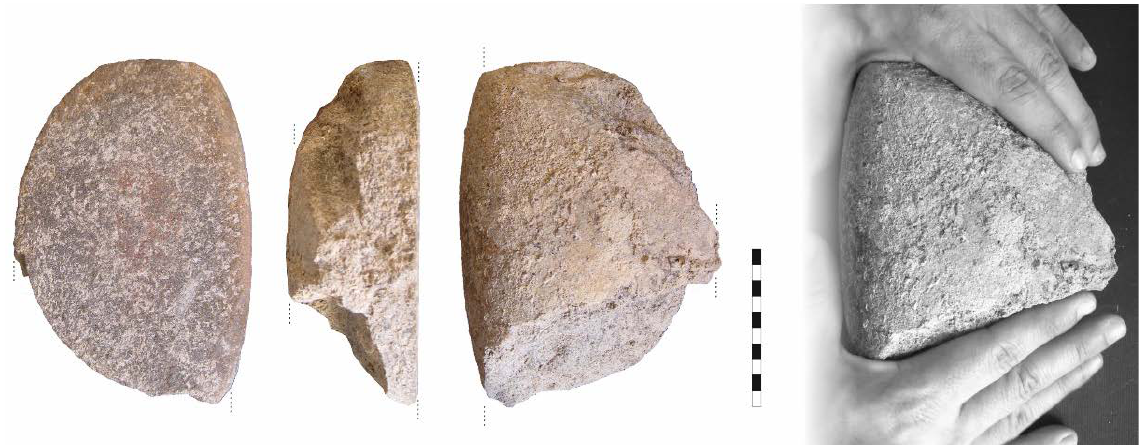
Figure 6. Grinding slab redesigned through flaking in order to be used as a grinder. Workface, profile, dorsal face and suggested way of holding (scale in cm).